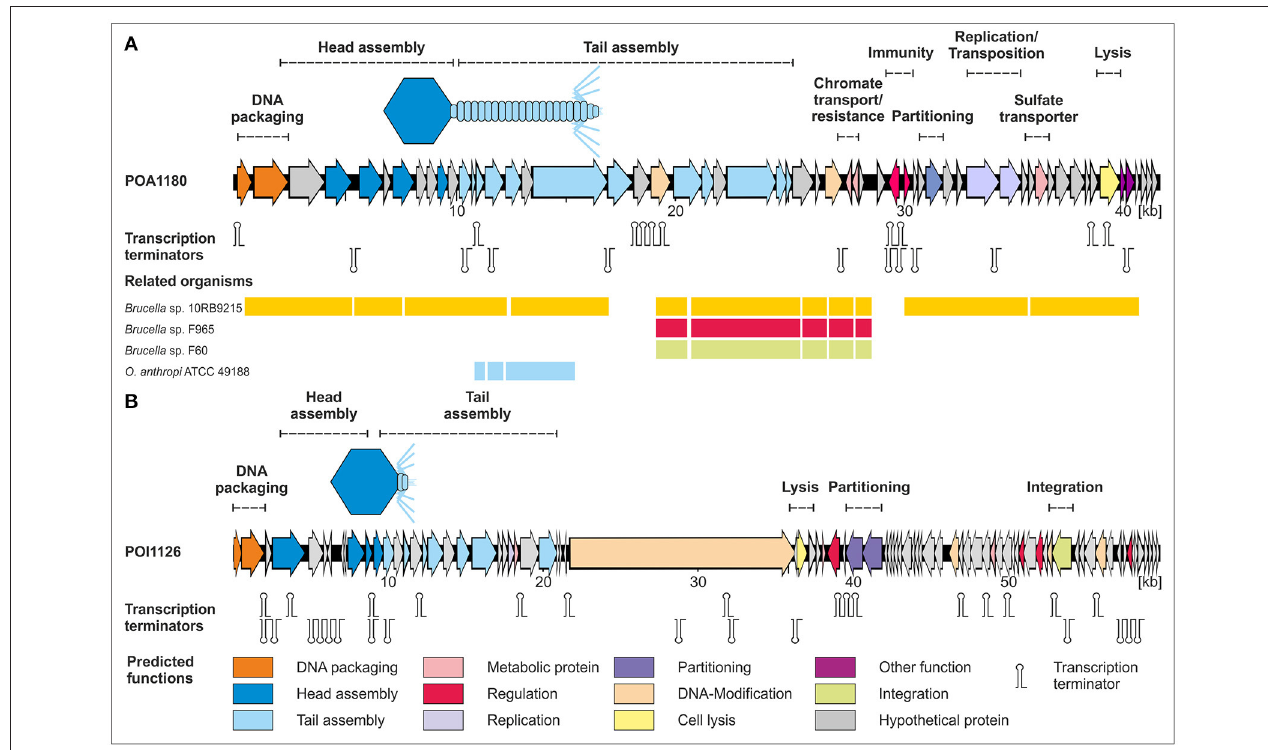
FIGURE 4 | Gene maps of the Ochrobactrum phages POA1180 (A) and POI1126 (B) . Putative genes are colored according to the predicted functions of their products. The position of putative Rho-independent transcription terminators and tRNAs are indicated. For POA1180 nucleotide similarities ( > 75%) to closely related Brucella and Ochrobactrum genomes are